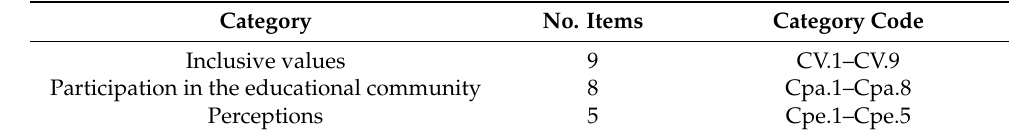
Table 1. Indicators of the questionnaire on inclusive culture. Category No. Items